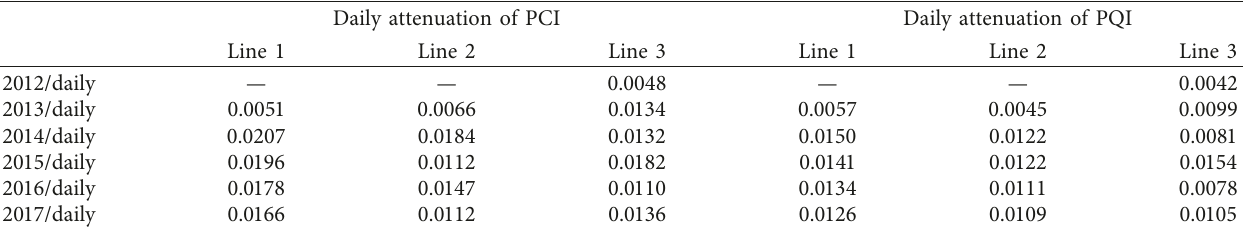
Table 7: Daily attenuations of PCI and PQI for three typical representative lines of main trunk highways in Hunan Province.